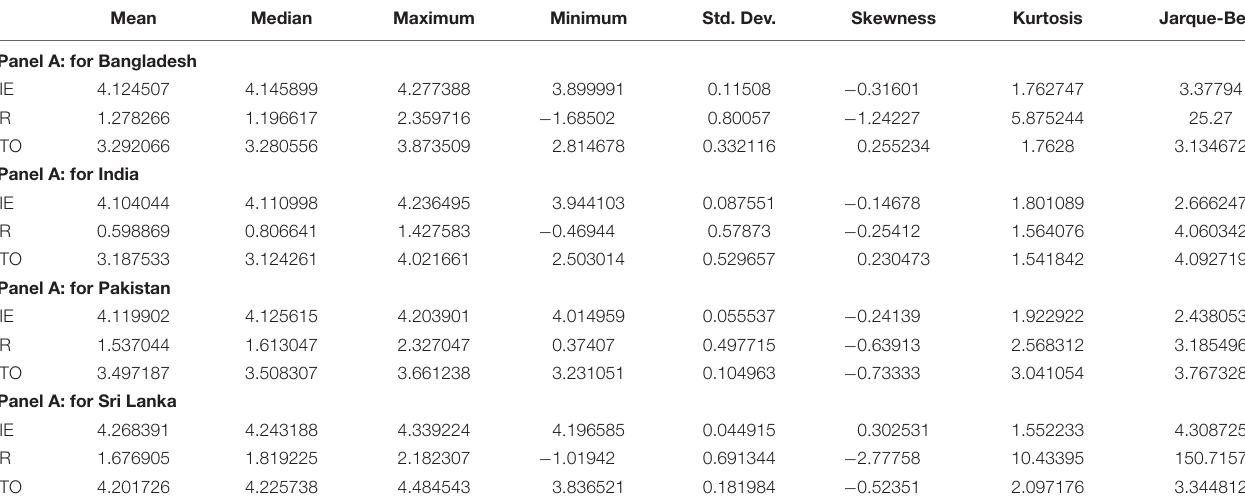
TABLE 1 | Descriptive statistics of research